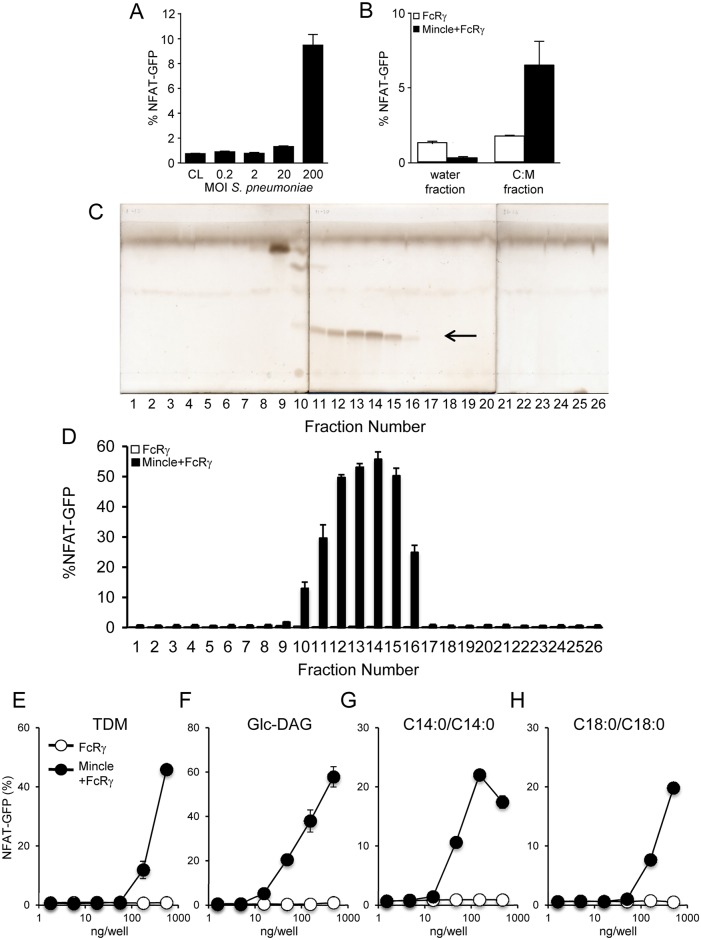
Characterization of glycolipid Glc-DAG purified from S. pneumoniae.(A) NFAT-GFP reporter cells (4 x 104 cells/well) were incubated with live S. pneumoniae at MOI 0.2, 2, 20 and 200 for 18 h followed by determination of the percentage of GFP-expressing reporter cells by flow cytometry. (B) FcRγ or Mincle+FcRγ expressing NFAT-GFP reporter cells (4 x 104 cells/well) were incubated with aqueous or C:M fraction of S. pneumoniae lysates for 18 h, followed by determination of GFP-expressing reporter cells by flow cytometry. (C) HPTLC result of HPLC fractionated C:M portion of pneumococcal lysates with putative ligand indicated by an arrow head (copper acetate stain). (D) FcRγ (white bars) or Mincle + FcRγ (black bars) NFAT-GFP reporter cell assay of HPLC fractions obtained from scratched and purified HPTLC bands of S. pneumoniae lysates shown in (C). Experiments were repeated three times with similar results. See also S2 Fig. (E-H) Effect of TDM (E), or S. pneumoniae-derived Glc-DAG (F), or synthetic Glc-DAG (C14:0/C14:0, (G), or C18:0/C18:0, (H)) to trigger GFP reporter activation in Mincle/FcRγ (black dots), or FcRγ only (white dots) expressing NFAT-GFP reporter cells.